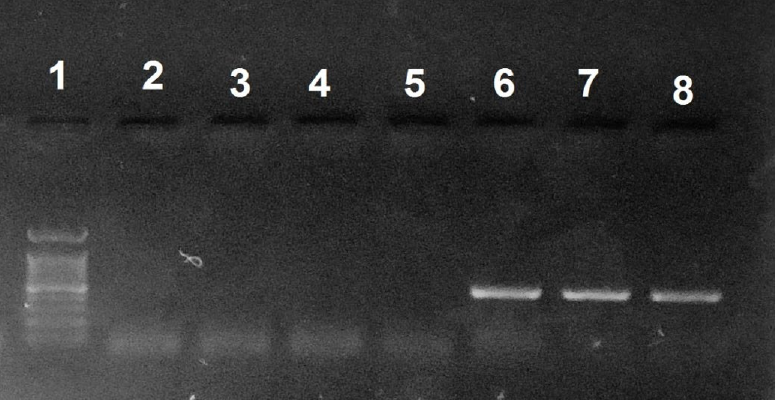
gene in A. baumannii isolates. Lane 1 was 1kb DNA ladder, oxa-23like positive A. baumannii isolates while lanes 2, 3, 4 and 5 oxa-23like gene